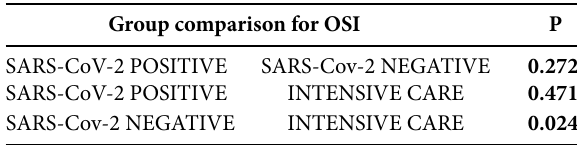
Table 2: Calculated differences between groups.